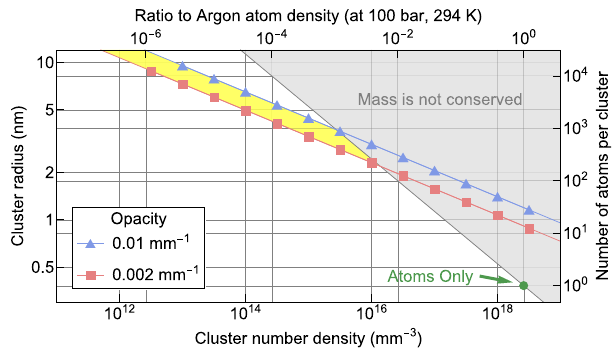
Fig. 4 Expected number density and size of the clusters to explain the opacity. The gray shaded area is forbidden because the number of atoms exceeds the total number of atoms for the given chamber condition (100 bar, 294 K). The clusters should have density and size within the yellow shaded area. The green dot corresponds to the opacity for the case of atoms only (i.e.,